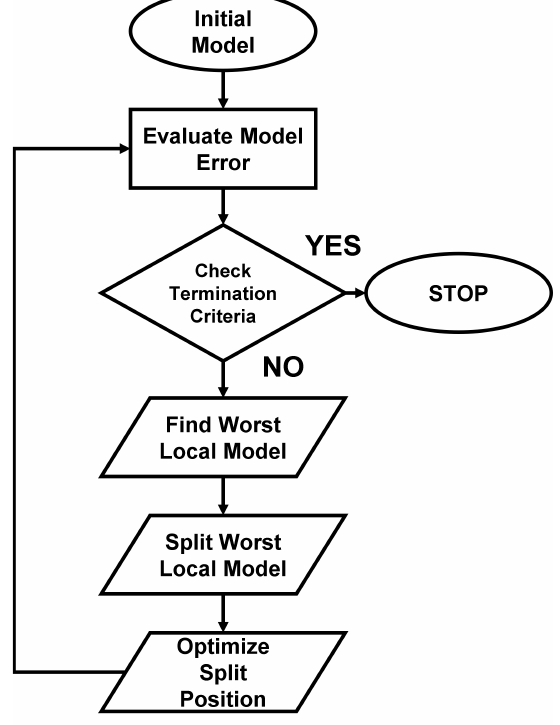
Figure 2. Algorithm flowchart for the HILOMOT algorithm. The HILOMOT algorithm replaces the worst local model with new local models at every iteration. Figure 3 demonstrates the hierarchical decomposition of the input space.